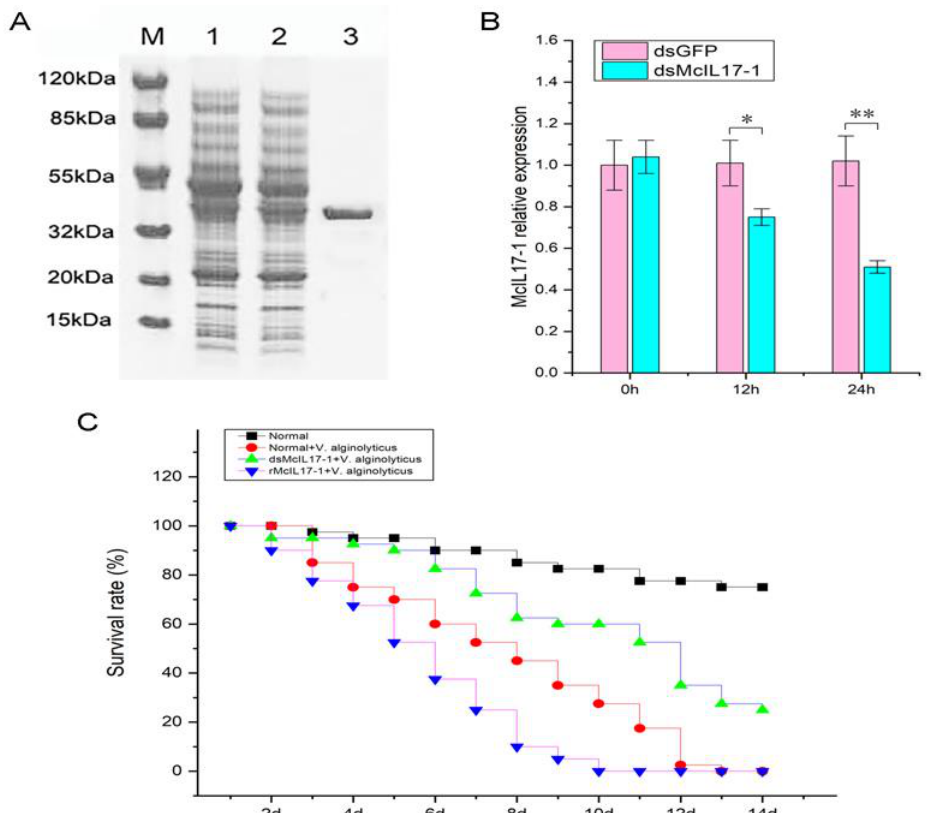
Figure 5. Effects of silencing and overexpression of Mc IL17-1 on survival rate of mussels. ( A ) SDS- PAGE analysis of r Mc IL17-1. Lane M: protein molecular standard; lane 1: negative control for r Mc IL17-1(without induction); lane 2: transfected r Mc IL17-1; lane3: purified r Mc IL17-1. ( B ) Mc IL17- 1 was silenced through dsRNA injection. ( C ) The survival rate (%) of mussels prior to ds Mc IL17-1 and r Mc IL17-1 injection following V. alginolyticus challenge. **, p < 0.01, *, p < 0.05 versus the controls.